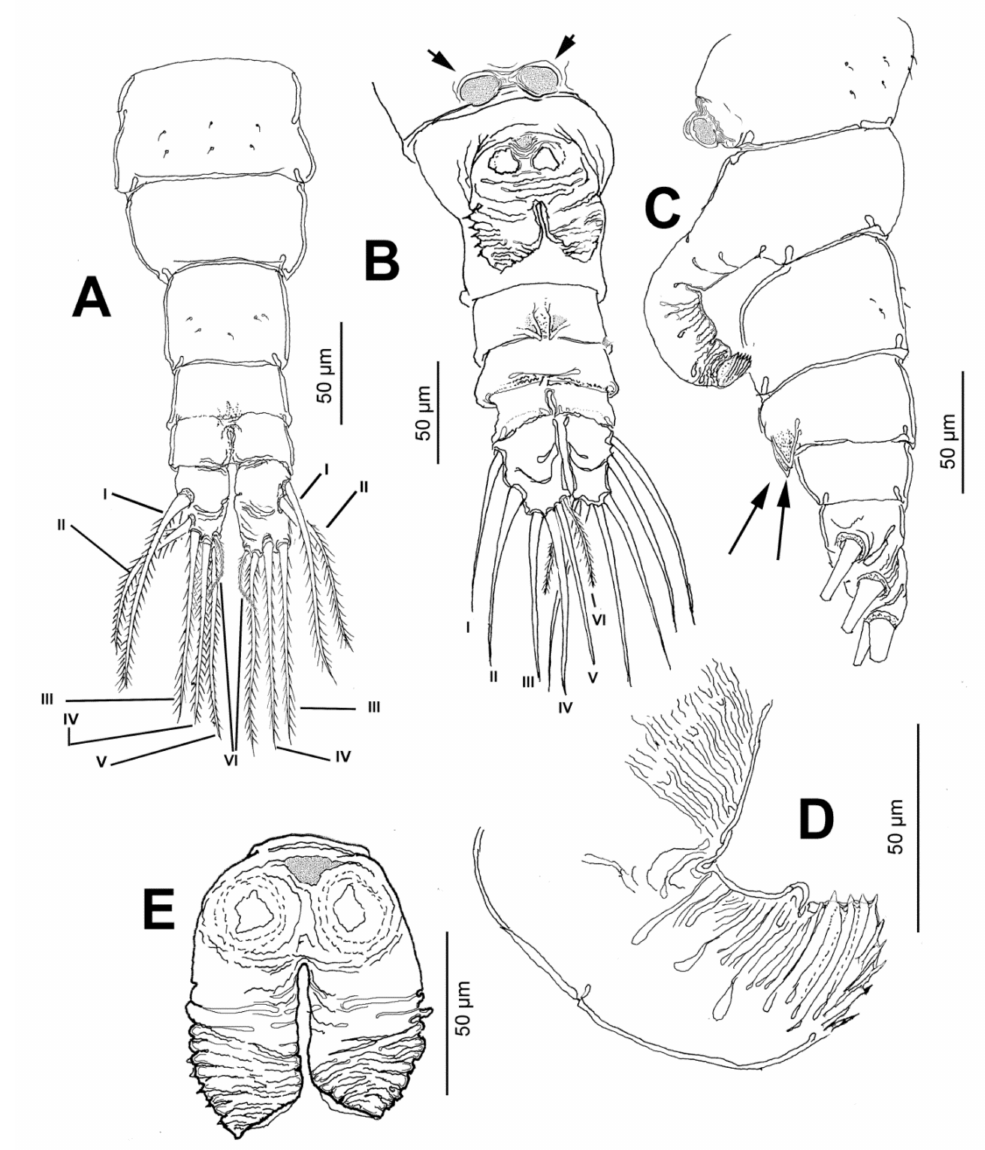
Figure 5. Caromiobenella brasiliensis (Dias and Su á rez-Morales, 2000) comb. nov., adult male (MNRJ30136). ( A ) Urosome, dorsal view; ( B ) Urosome, ventral view showing reduced knob-like fifth legs (arrows); ( C ) Urosome, lateral view showing genital complex with ventral keel-like processes arrowed; ( D ) Detail of genital lappets, lateral view; ( E ) Genital lappets, ventral